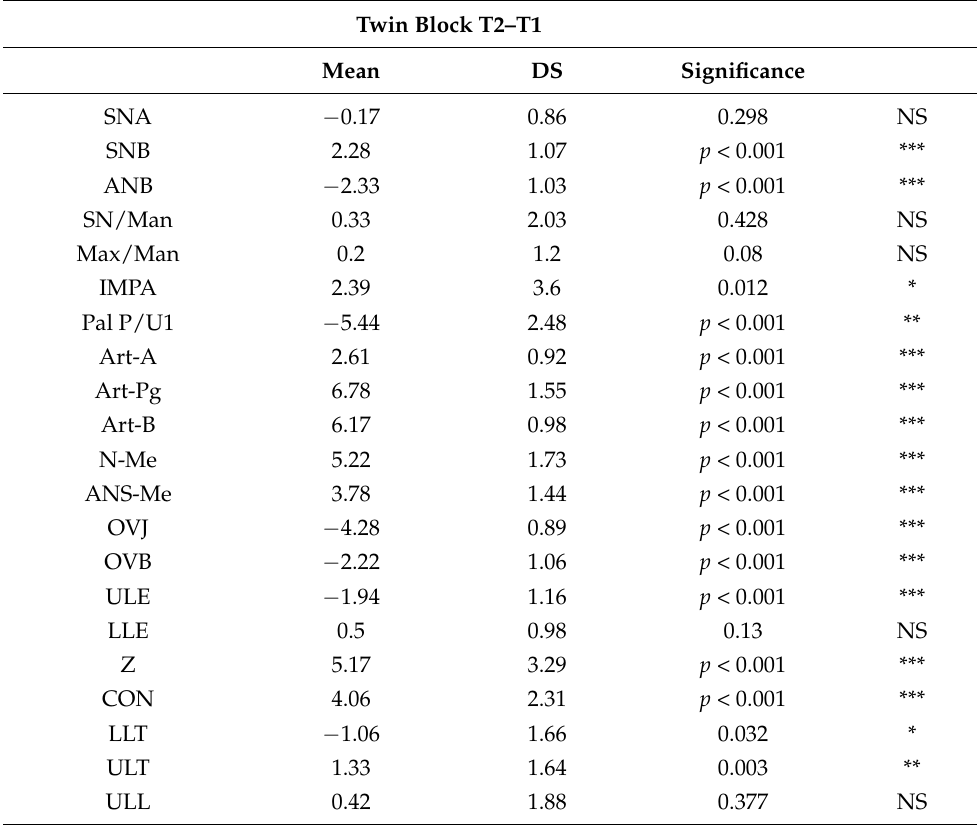
Table 4. Data collection of the differences in the variables considered between the time T1 and T2 for Twin